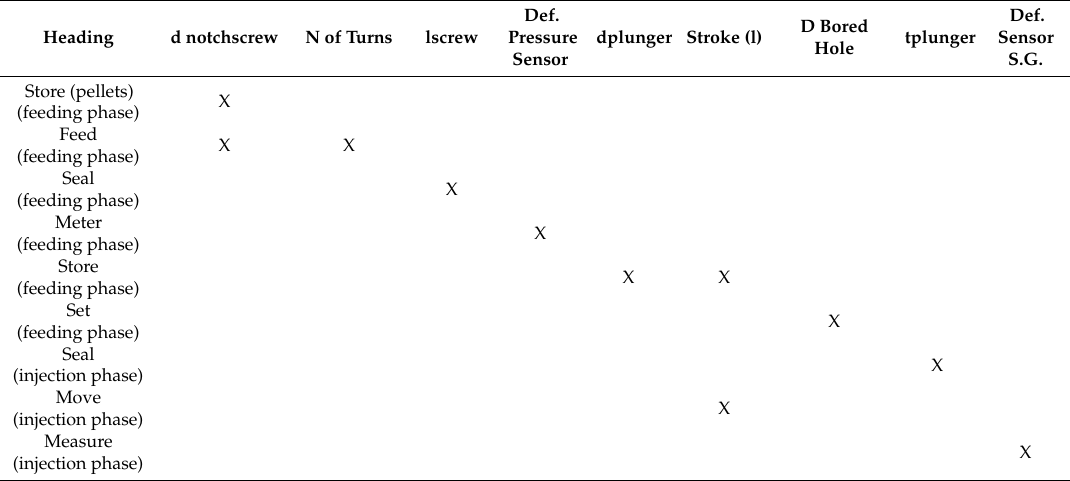
Table 9. Axiomatic matrix for the µ IM machine. Control functions are indicated in